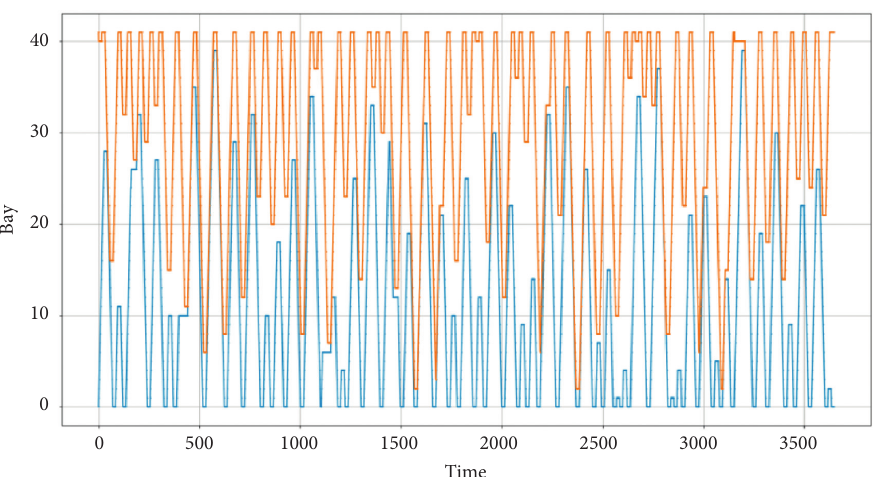
Figure 11: Tracks of the twin ASCs obtained using the algorithm based on graph theory.